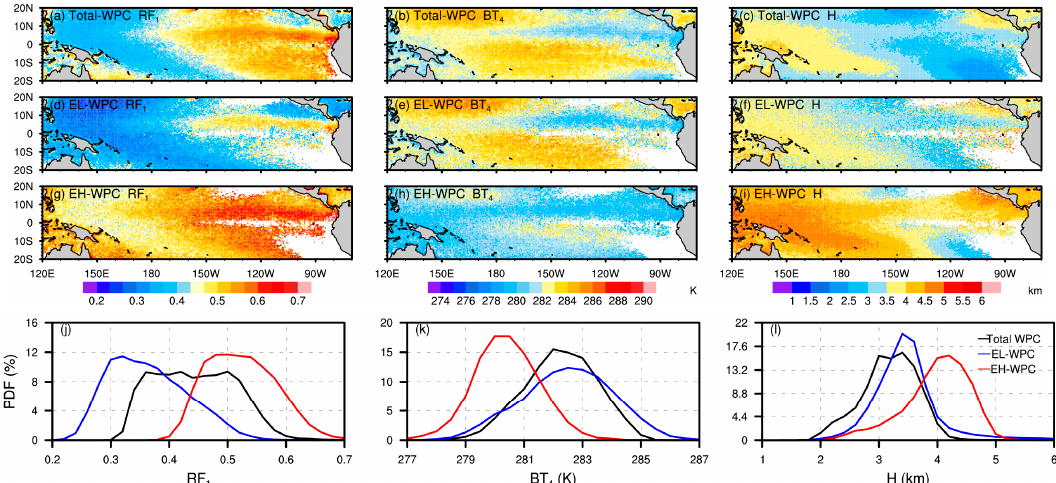
Figure 4. Distribution of ( left ) RF 1 (reflectivity in the 0.63 μ m), ( middle ) BT 4 (brightness temperature at 10.8 μ m) and ( right ) echo-top height (H) for ( a – c ) total-WPC, ( d – f ) EL-WPC and ( g – i ) EH-WPC, along with ( j – l ) their probability distribution functions.